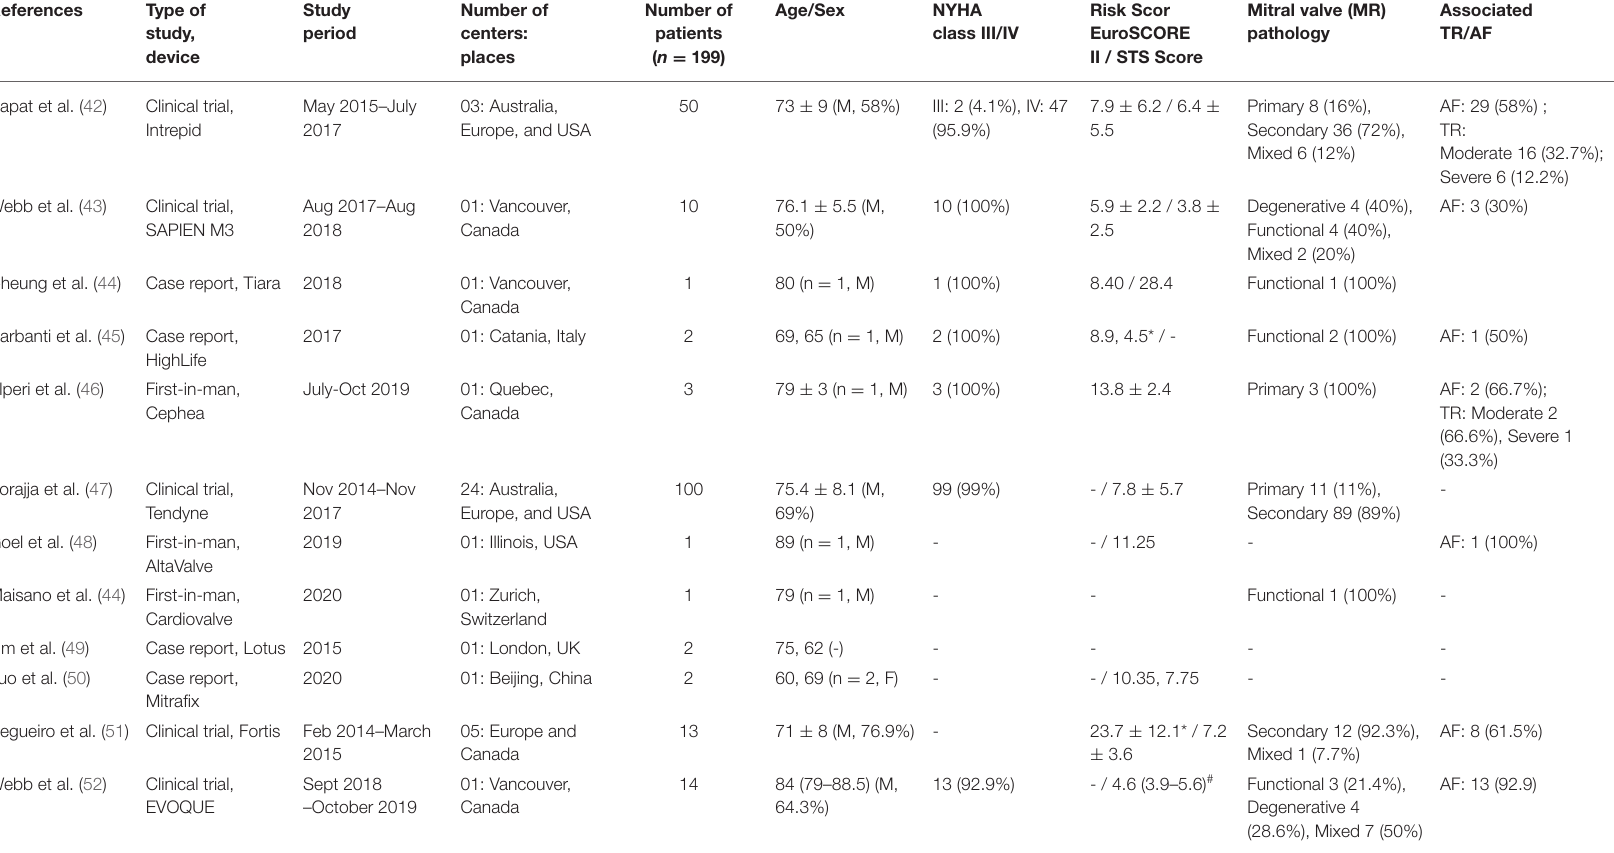
TABLE 1 | Summary of the included studies and baseline characteristics of